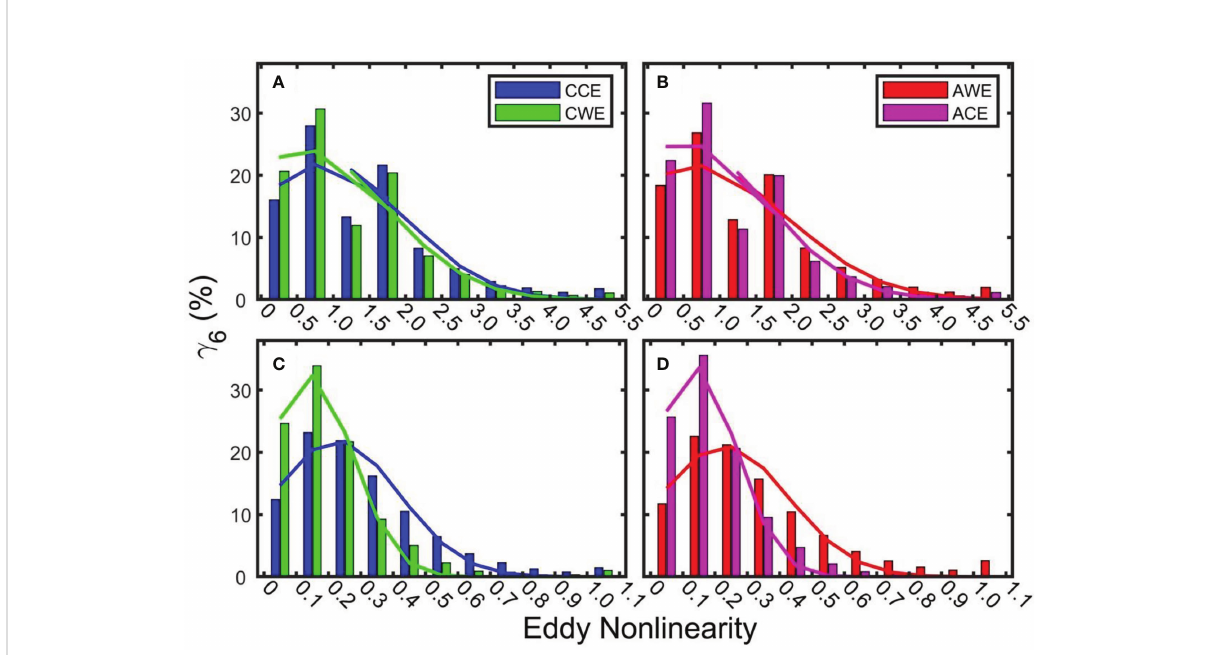
FIGURE 13 Statistical histogram of eddy nonlinearity at the surface (A, B) and 1,000 m (C, D) . Blue, red, green, and magenta bars represent cyclonic cold- core eddy, anticyclonic warm-core eddy, cyclonic warm-core eddy, and anticyclonic cold-core eddy, respectively. The curves show the distribution of the Gaussian fi tting